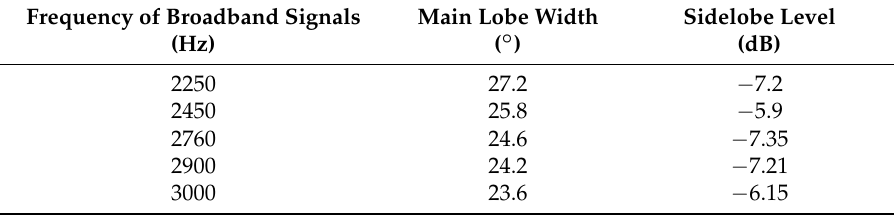
Table 2. Comparison of beamforming parameters for broadband signals.